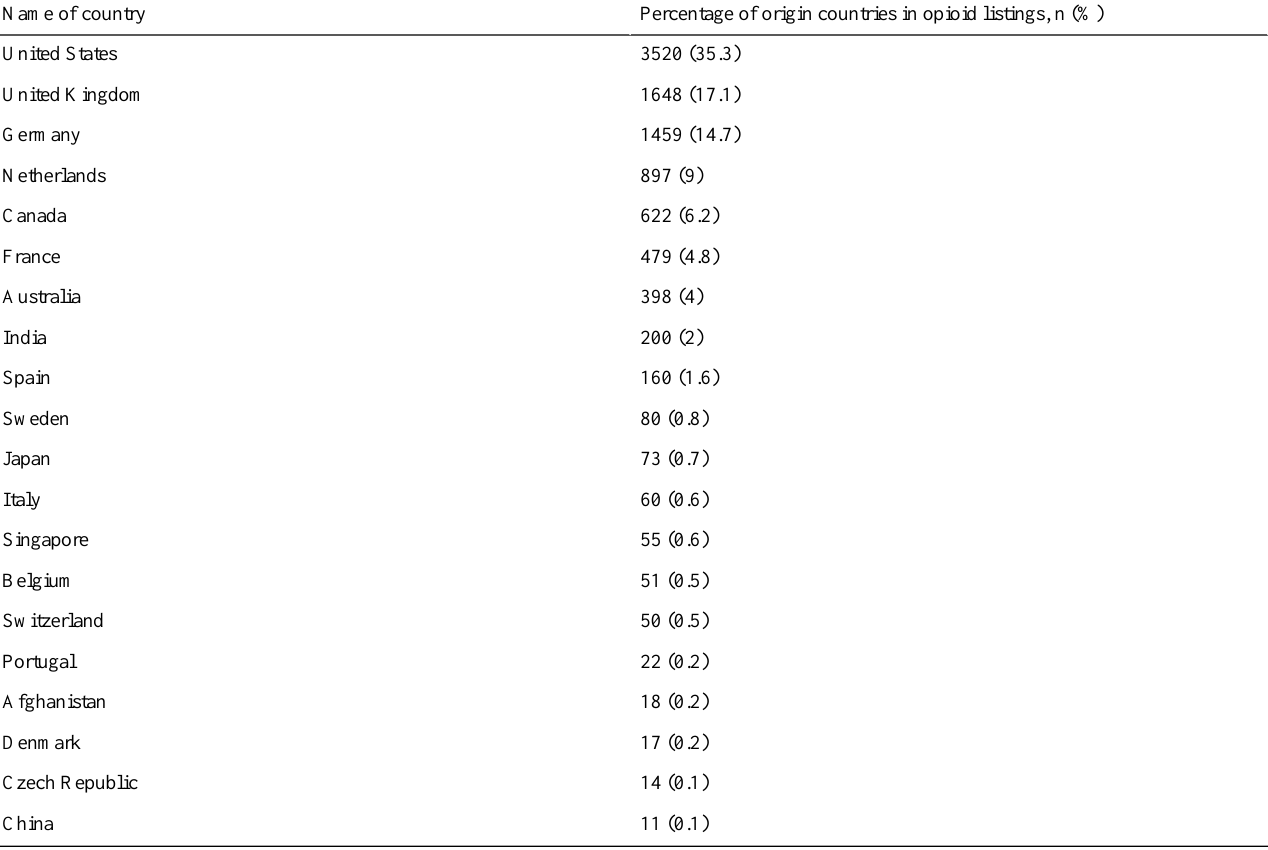
Table 7. The advertised origin